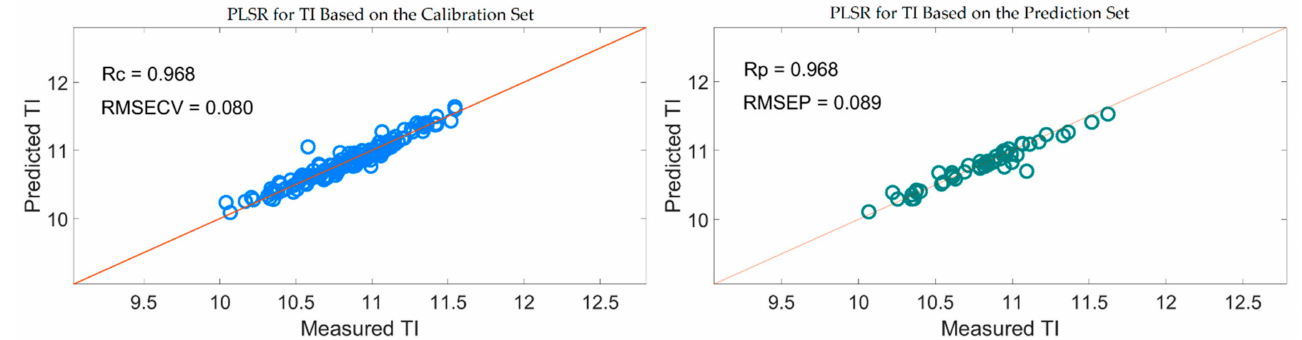
Figure 16. PLSR model for TI based on the useful wavelengths selected by